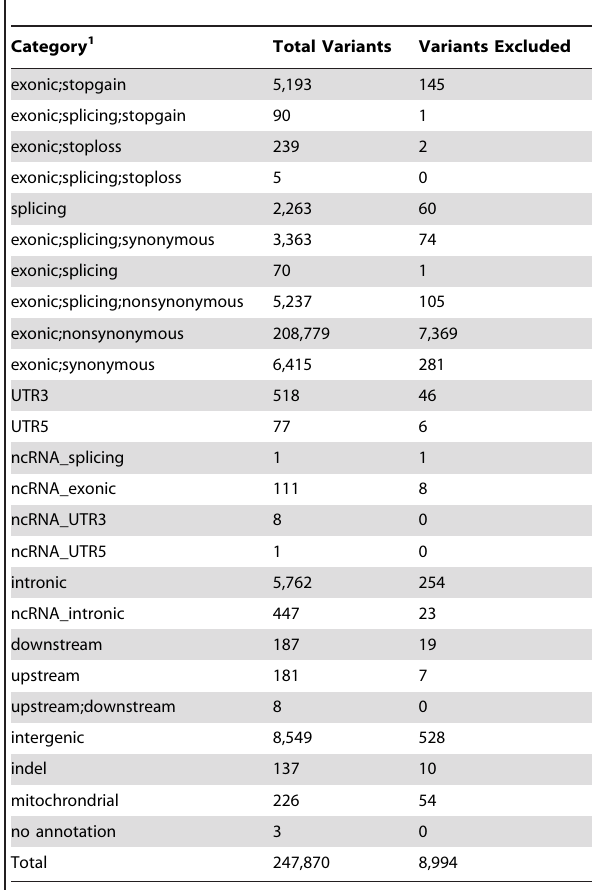
Table 6. Exome chip content and CHARGE excluded variants by functional